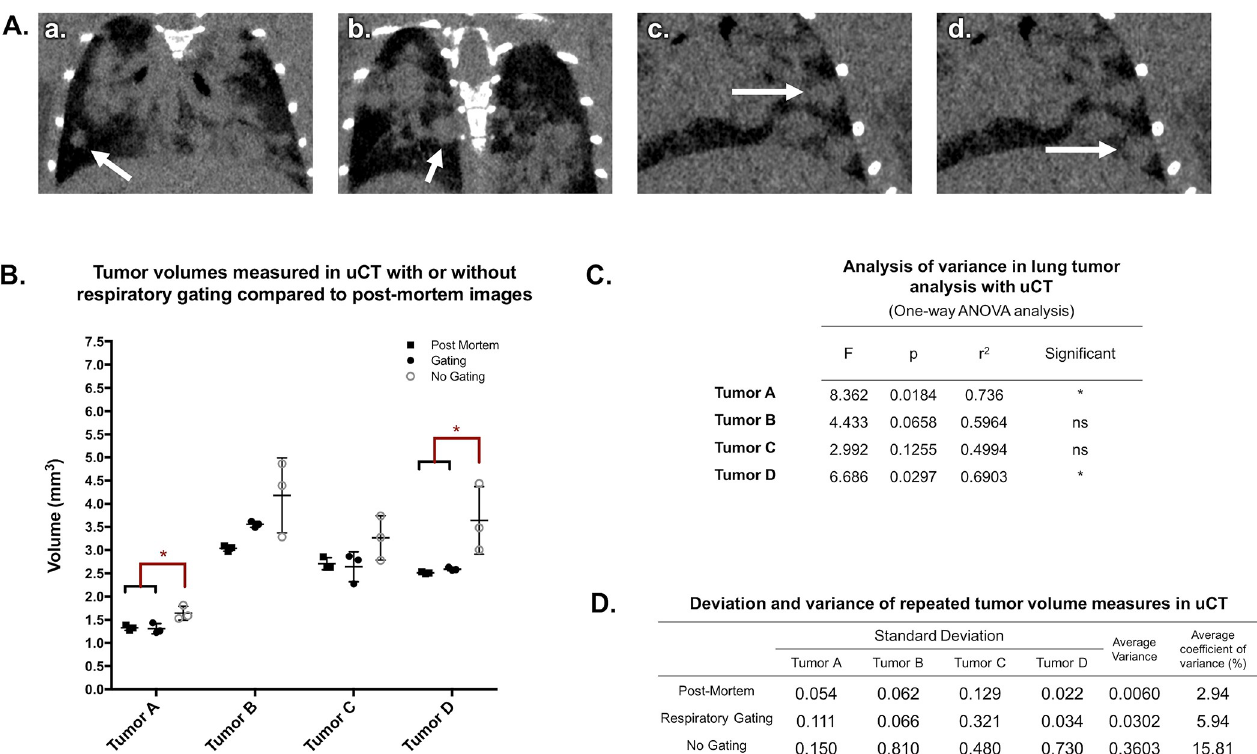
Fig 9. Respiratory gating improves precision and accuracy of lung tumor volume assessment in a free-breathing mouse. Multiple tumors of varying size and location in the lungs of a free-breathing mouse scanned with micro-CT were identified (A, a-d). Hand-drawn ROIs were used to calculate the volume of each lesion in each scan (a total of 9 measurements per tumor). ANOVA showed that in half of the lesions, respiratory gating had a significant impact on the accuracy of volume measurement (B and C). Variance within repeated measures from gated images was approximately double that of post-mortem images, while non-gated image results demonstrated more than five-fold variance compared to post-mortem measurements (D).